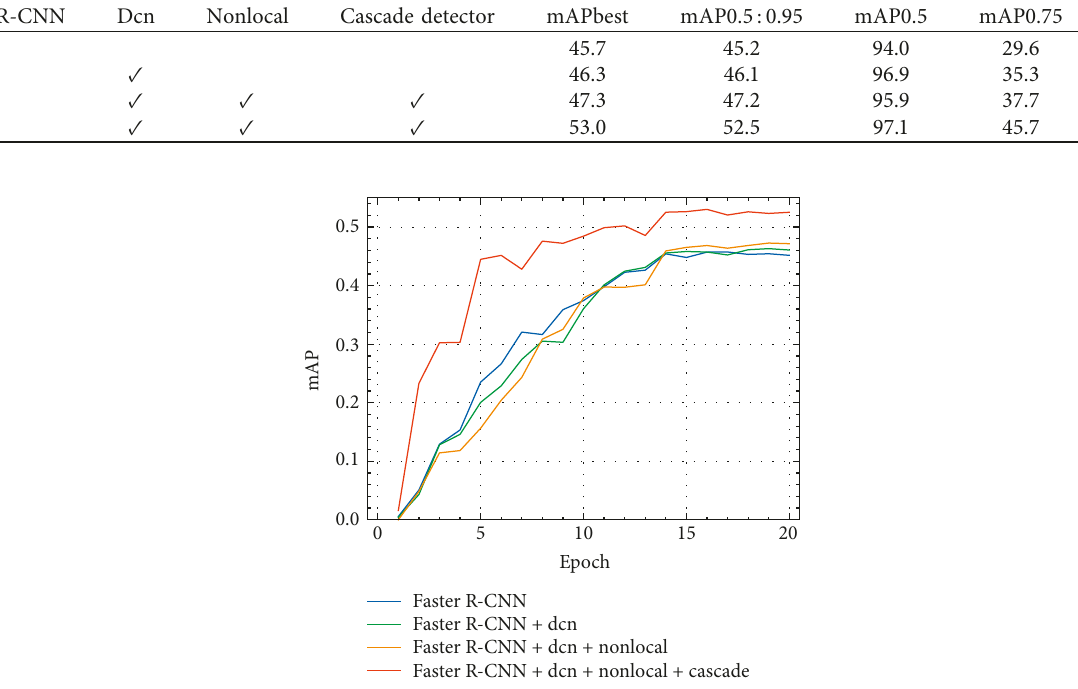
Figure 8: Visualization of the retrained Faster R-CNN curve in mAPbest.